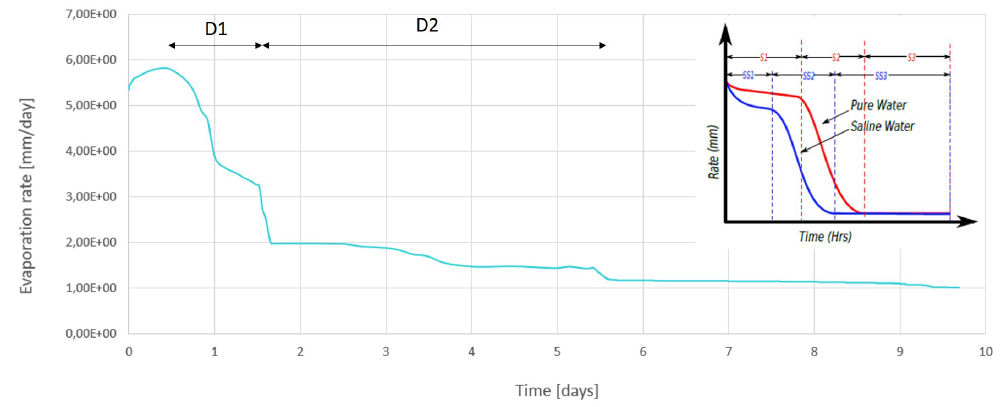
Figure 15. Variation of the evaporation rate during 10 days simulation